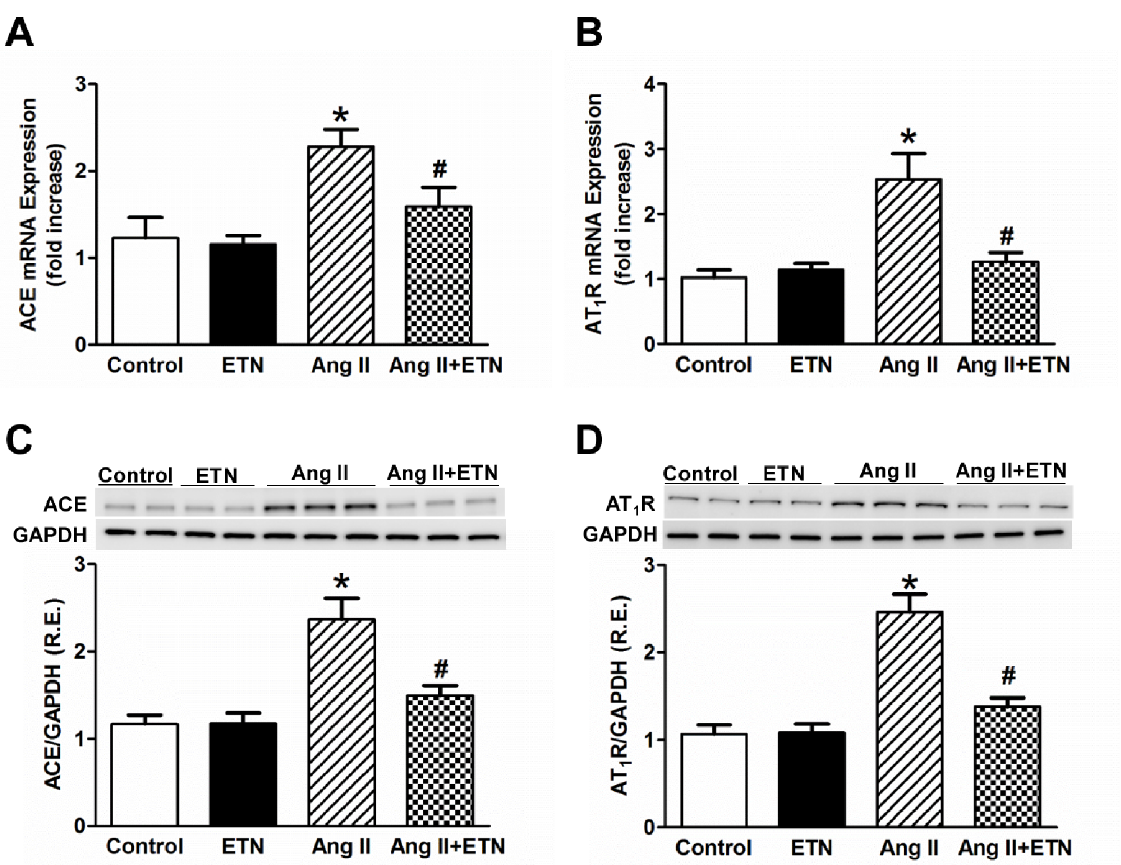
Figure 3. Effect of central TNF blockade on pro-hypertensive RAS component expression in the PVN. Chronic Ang II infusion for 4 weeks significantly increased the mRNA and protein expression of pro-hypertensive components, ACE and AT 1 R in the PVN, which was attenuated in Ang II + ETN rats. R.E. Relative expression, n=8–12 per group, * p , 0.05 vs Control, # p , 0.05 vs Ang II.